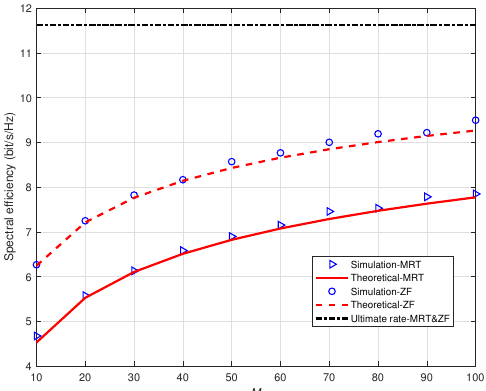
Figure 3. Spectral efficiency against M with MRT and ZF precoders.